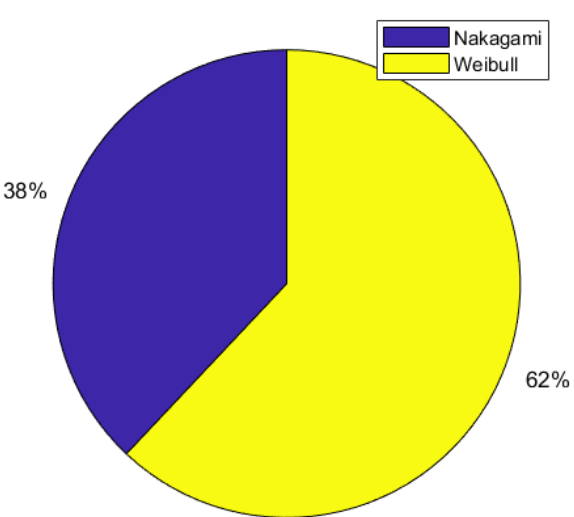
Figure 11. Percentage of best fitted distribution functions regarding fast variations within the auditorium at 3 GHz band in LoS conditions.